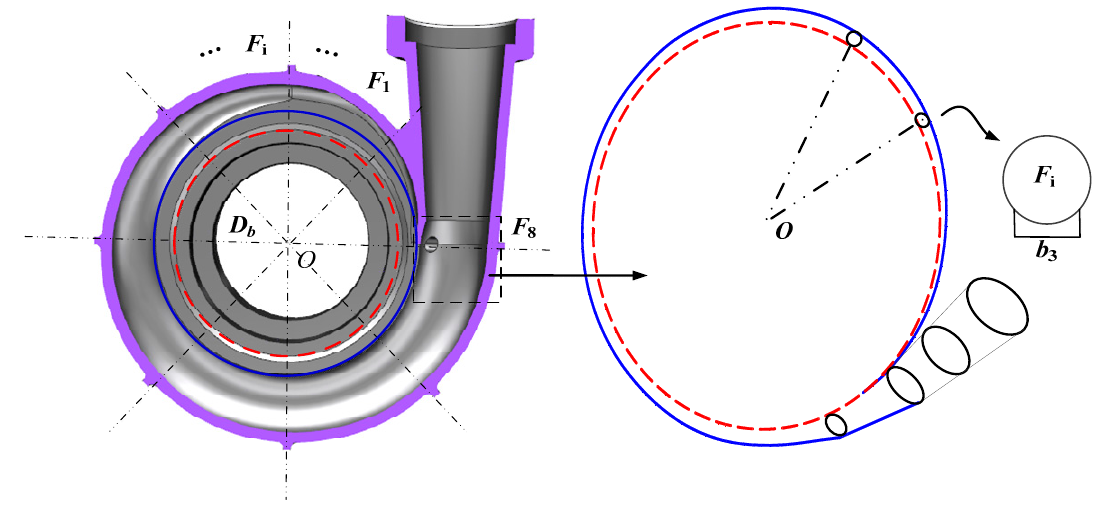
Figure 3. Geometric drawing process of volute.